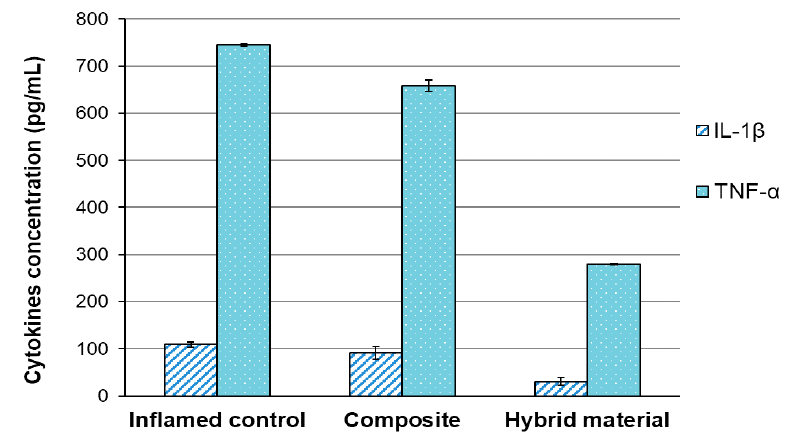
Figure 1. The effect of polymeric biomaterials on secretion of IL-1 β and TNF- α in inflamed THP-1 cells, determined by ELISA sandwich assay. * p <